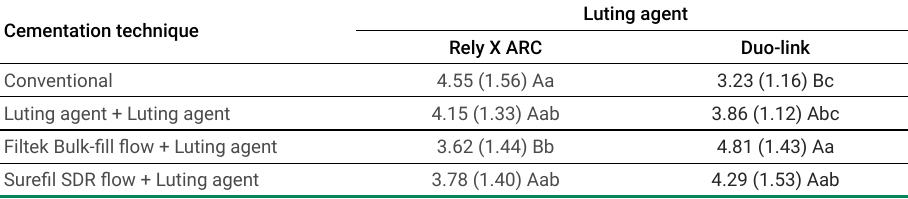
Table 2. Mean (standard deviation) push-out bond strength (MPa) of glass fiber posts cemented by different techniques. Cementation